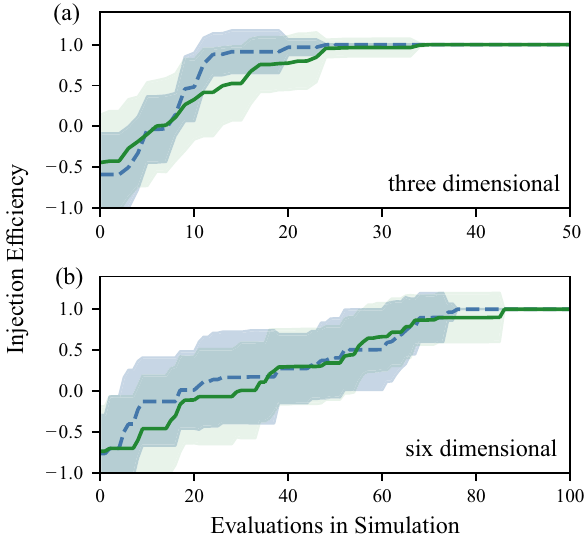
FIG. 4. Optimization results in an AT simulation model using UCB (green, solid) and EI (blue, dashed) acquisition functions for the (a) three- and (b) six-dimensional problems. The lines depict the best-evaluated injection efficiency in each run, aver- aged over ten independent runs. The shaded areas are the one σ spread. Within 50 and 100 steps for three- and six-dimensional problems, respectively, all the optimization runs converged to the optimum setting. The required steps for convergence increase with the input dimensions and both acquisition functions have a similar performance.